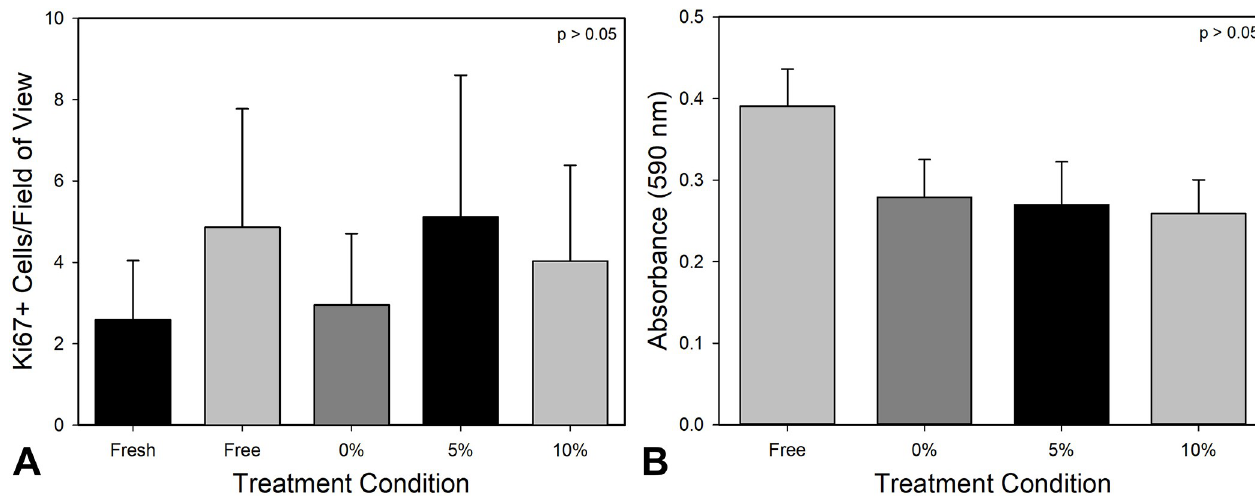
Fig 4. Ex vivo expansion does not significantly alter cell proliferation or metabolism. A) Quantification of Ki67 + cells per field of view as a function of culture condition. B) MTT cellular metabolism assay performed on punch biopsies collected from periosteum on culture day 10.